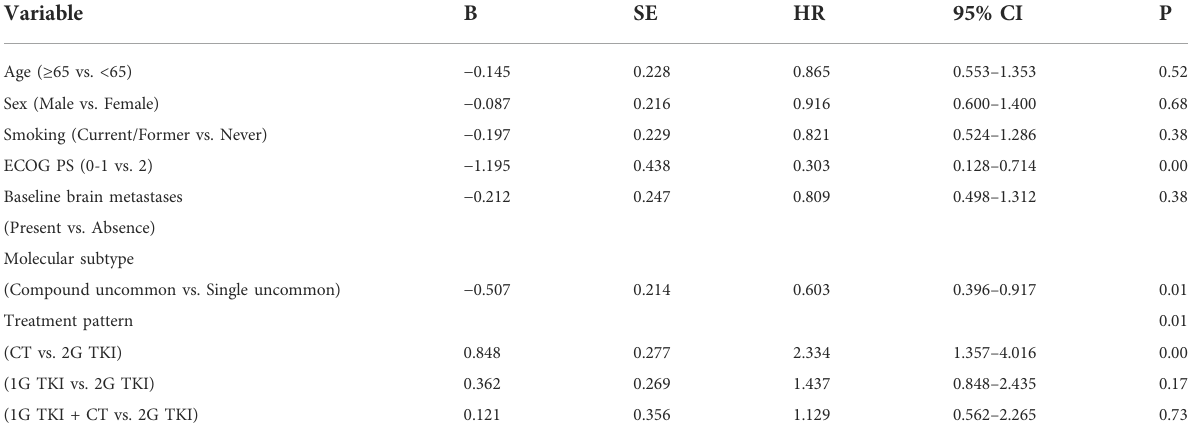
TABLE 3 Univariate survival analyses for PFS.